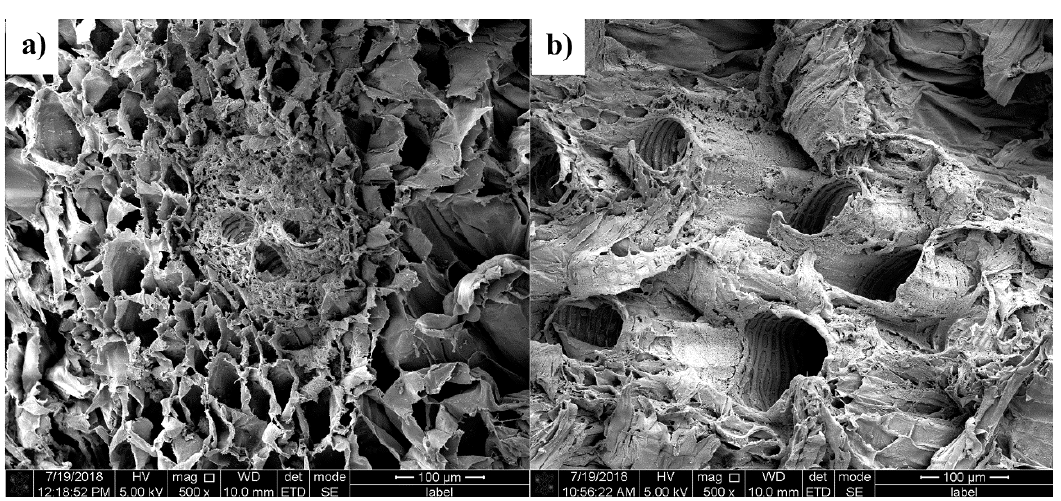
Figure 5. FESEM micrograph of cross-section root: ( a ) control; ( b ) Ni exposure.